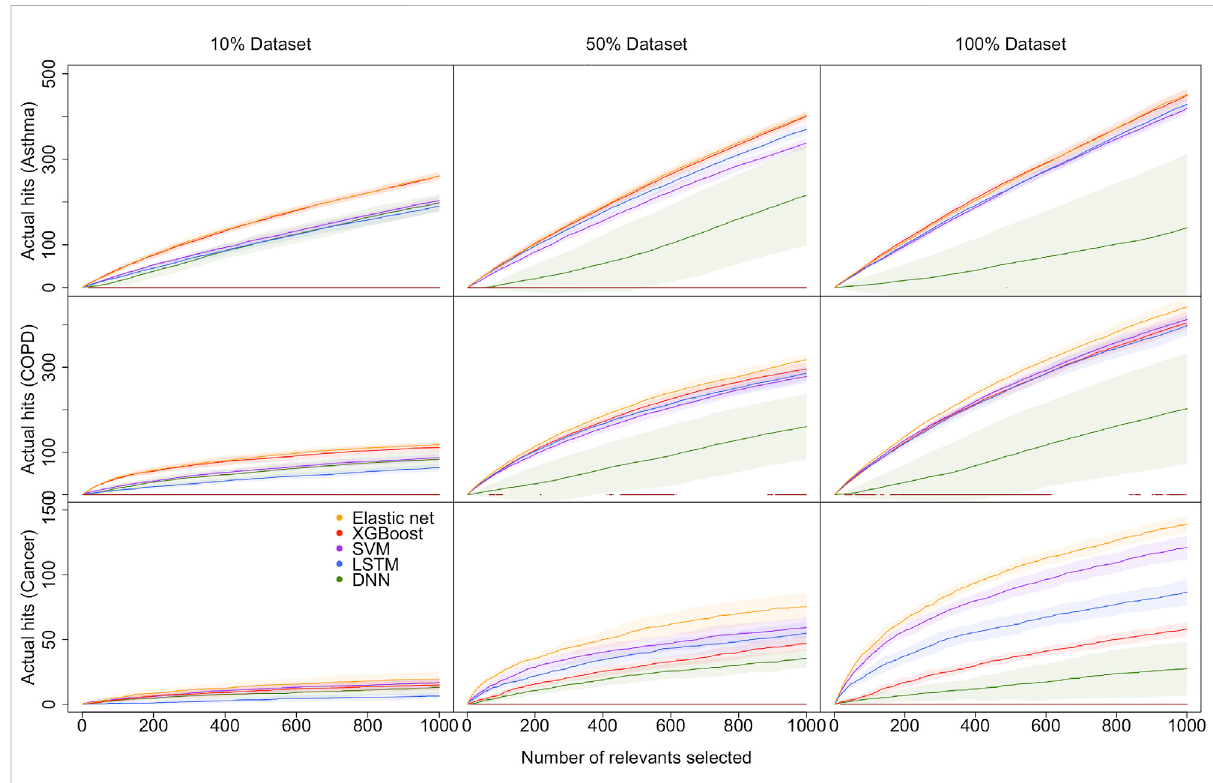
FIGURE 3 Hit curve graphs of AsthmaStatus, COPDStatus and CancerStatus classi fi cation by fi ve models on 10 – 100% data sets. The x-axis represents the number of test subjects we selected by sorting the estimated probability up to down. The y-axis of the hit curve chart represents the number of subjectswithcertainconditionswhicharecorrectlydiagnosedinthetestset.Thepoint( m 1 , m 2 )indicatesthereare m 2 patientsinthe fi rst m 1 selected subjects are correctly predicted as diseased. The curves show the average hit curves of fi ve models, and the shaded area denotes the con fi denceboundsconstructedusing10-fold cross-validation (i.e.±onestandarderror).Thebrownbaratthebottommeansnon-deepMLmodels are signi fi cantly better than DL